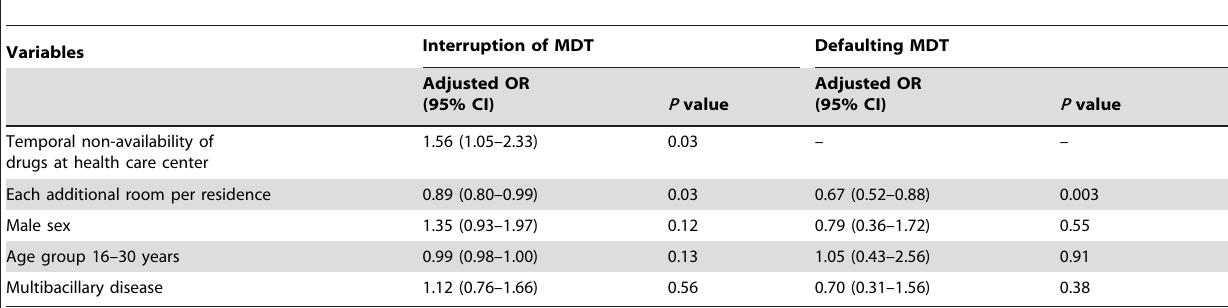
Table 2. Multivariate logistic regression analysis of factors associated with interruption of, and defaulting multidrug therapy against leprosy, adjusted by sex, age and disease